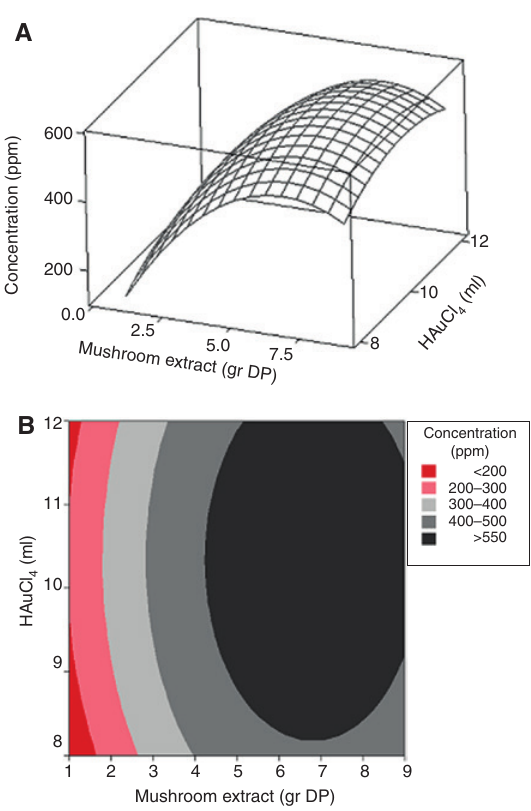
and concentration max